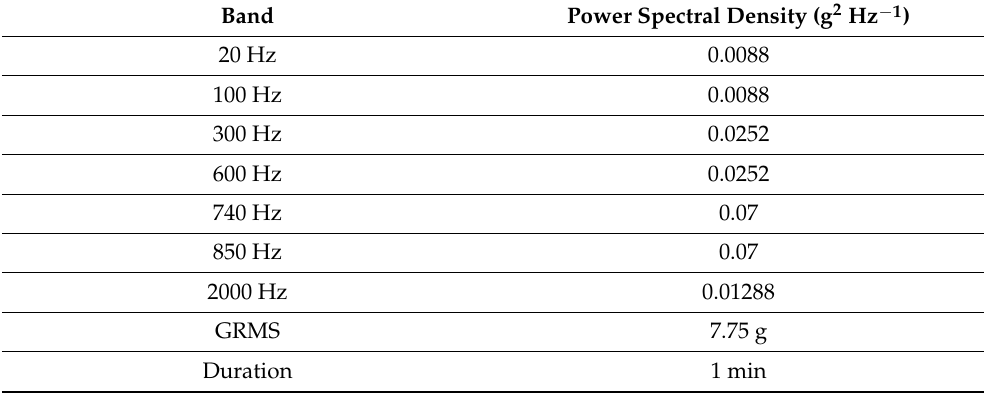
Figure 11. X and Y axis sine burst test specification of g-force acceleration (in units of g = 9.8 m s −2 ) with respect to time. Table 10. Random vibration test specification.